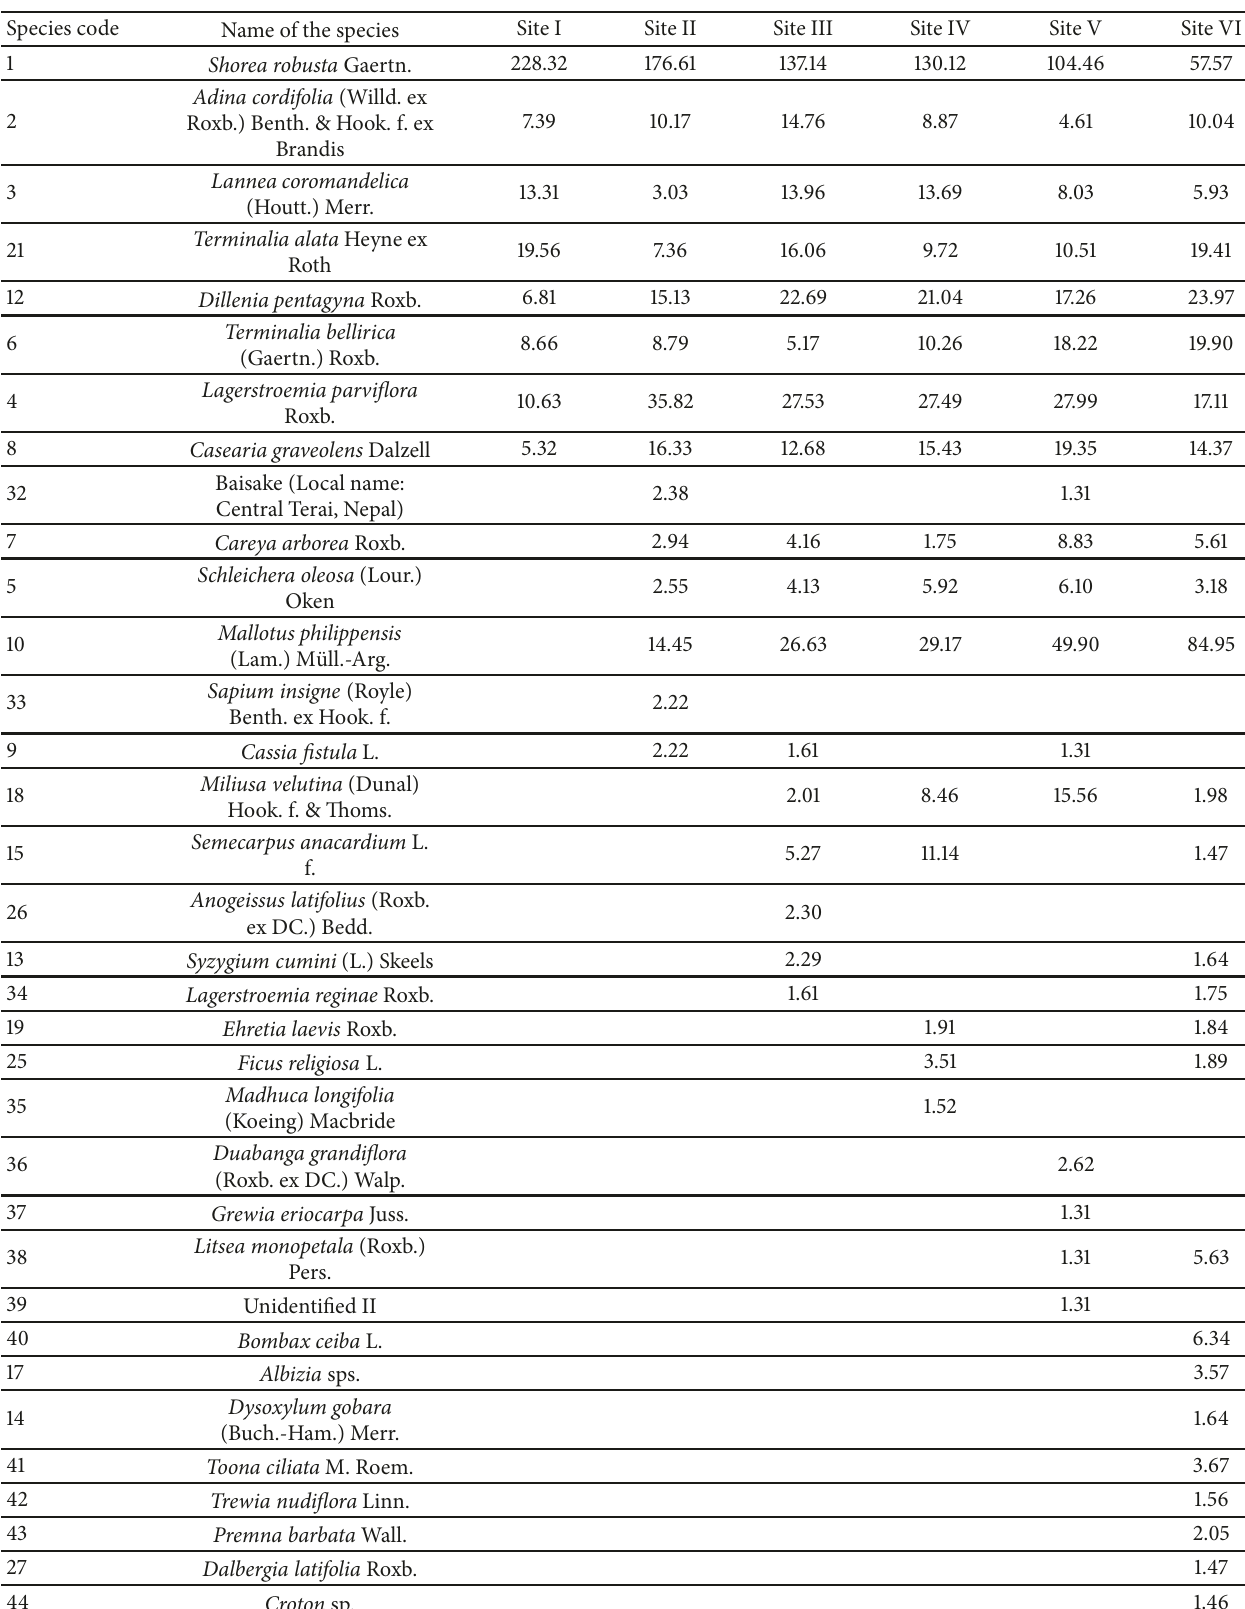
Table 9: IVI of species in Radha Krishna